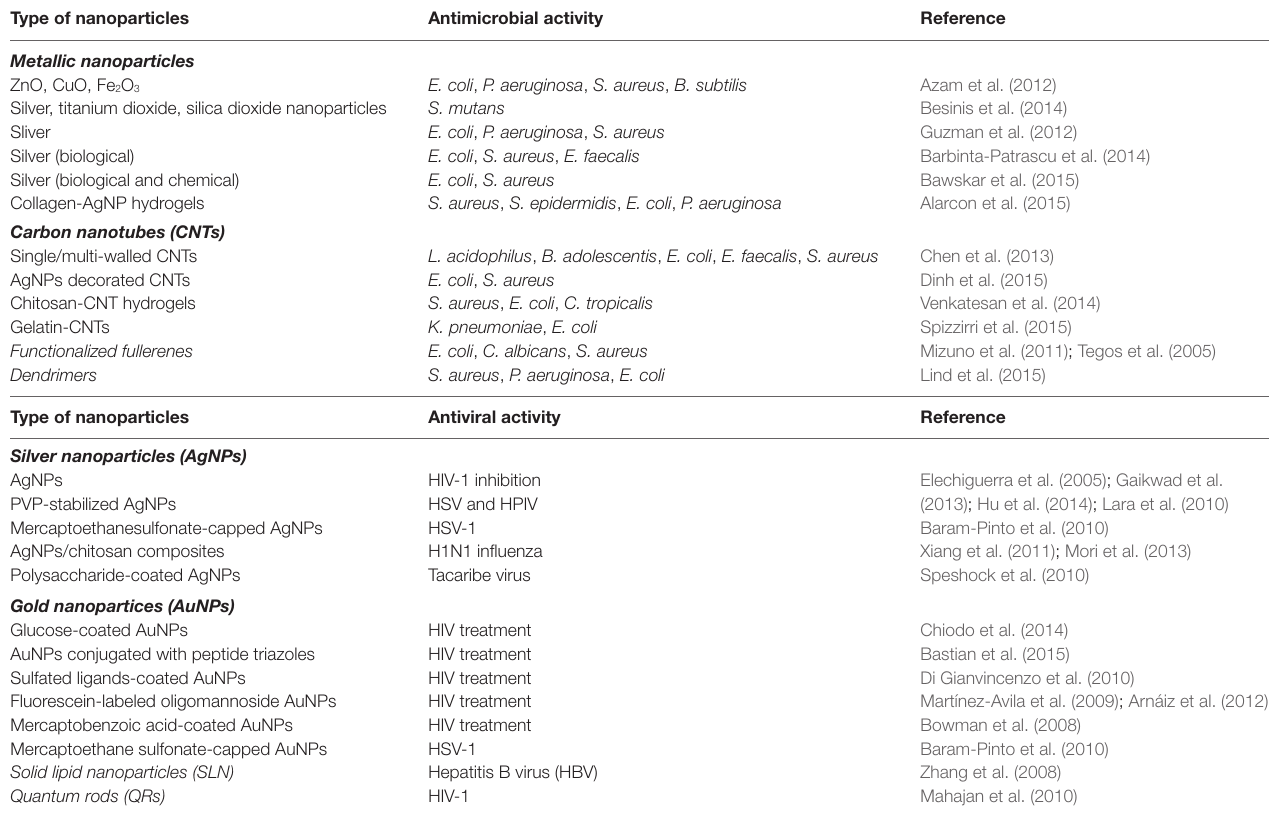
TABLe 1 | Type of various nanoparticles and their applications in antimicrobial and antiviral treatment. Type of